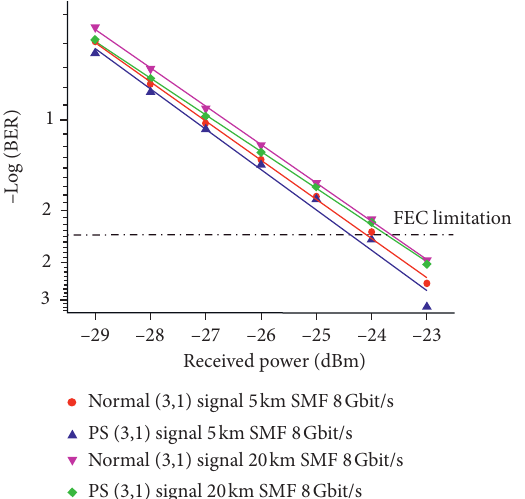
Figure 8: BER of the normal (3, 1) signal and the PS (3, 1) signal versus received optical power for 5km and 20 km SMF trans- mission at 8Gbit/s, respectively.